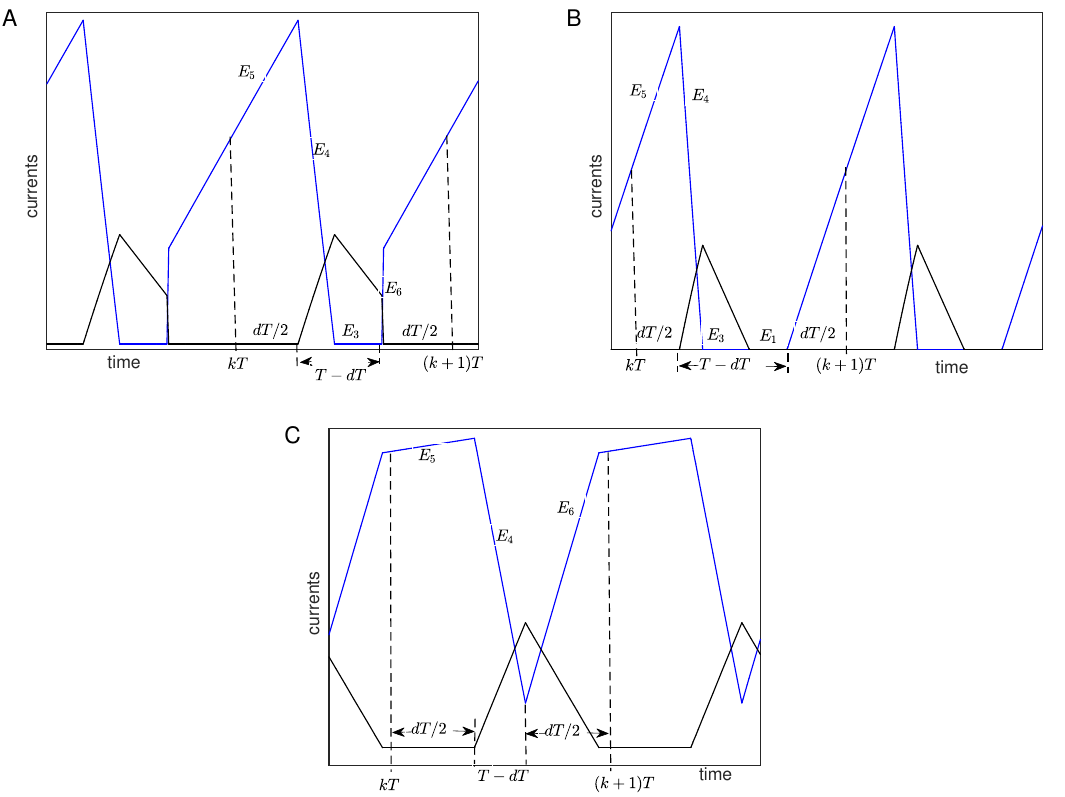
Figure 3. Three possible periodic orbits in the boost-flyback converter. ( A ) Orbit following the topologies 5436. ( B ) Orbit 5431 and ( C ) Orbit 546. In all panels, the primary (secondary) current i P ( i S ) is depicted in blue